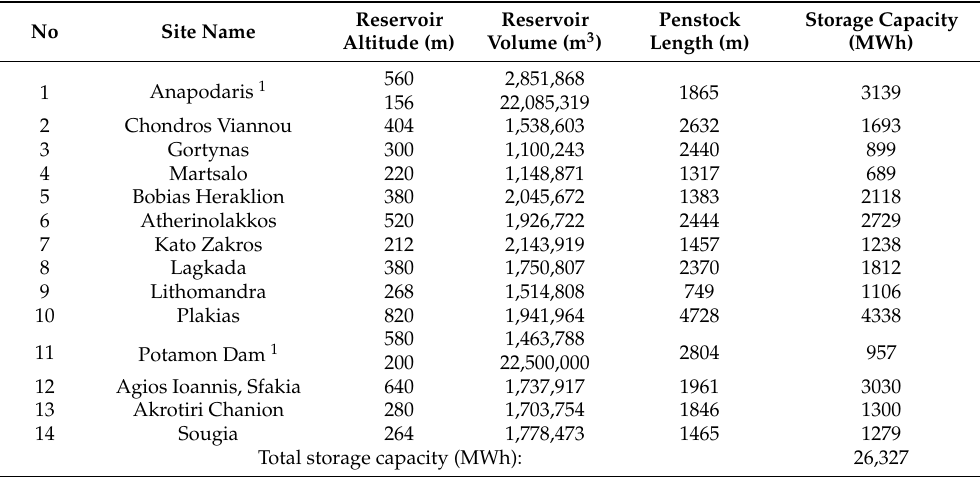
Figure 24. Location of the installation sites of the PHS plants on Crete. Table 10. Essential features of the selected sites for the installation of the PHS plants.